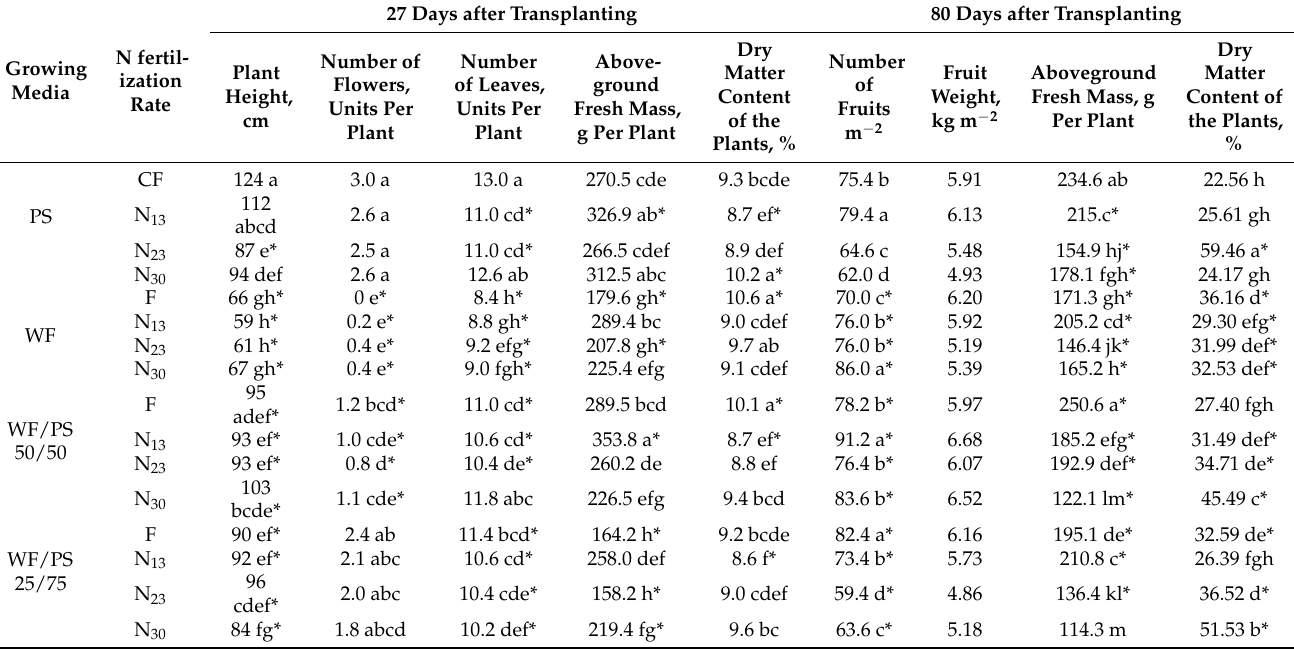
Table 1. The influence of four growing media: 100% peat substrate (PS), 100% wood fiber (WF), 50/50 wood fiber/peat by volume (WF/PS 50/50), and 25/75 wood fiber/peat by volume (WF/PS 25/75), and conventional fertilization (CF) or supplementary nitrogen fertilization with nitrogen N 13 , N 23 , of N 30 on the biometric parameters of